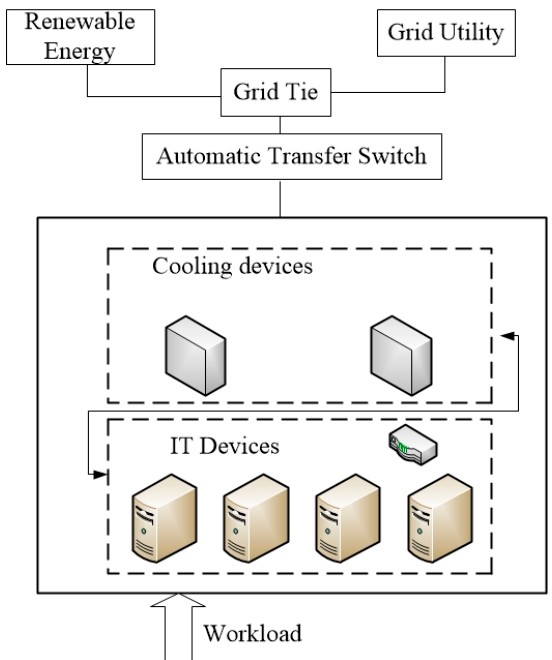
Figure 1. Green datacenter architecture.